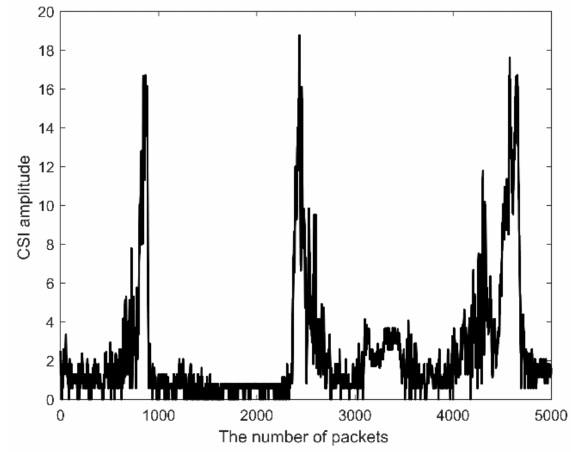
Figure 2. The signal before the filtering.